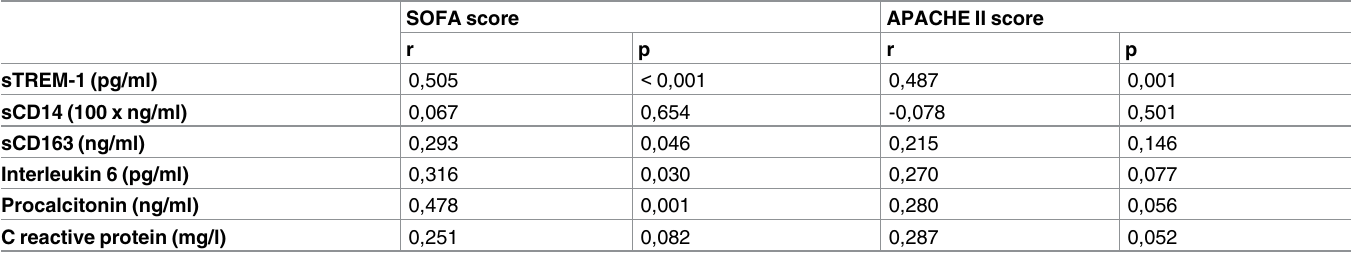
Table 3. Correlations among SOFA and APACHE II scores and serum concentrations of studied biomarkers in the overall group of patients. SOFA